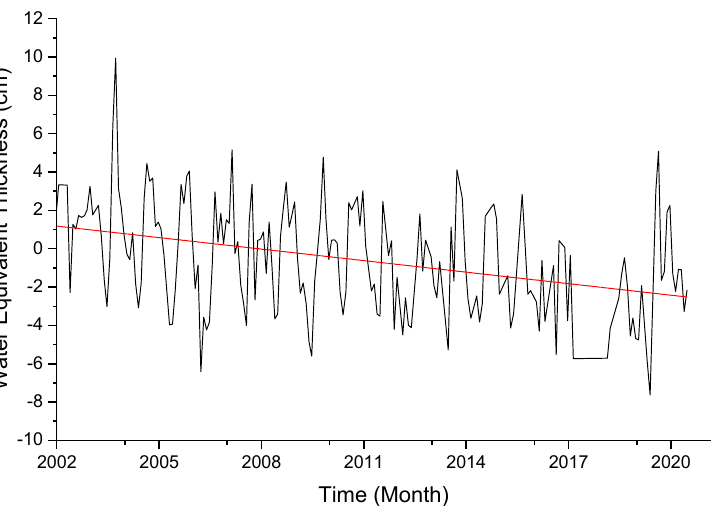
Figure 10. Groundwater equivalent thickness variation based on GRACE-FO datasets (2002–2020) JPL.